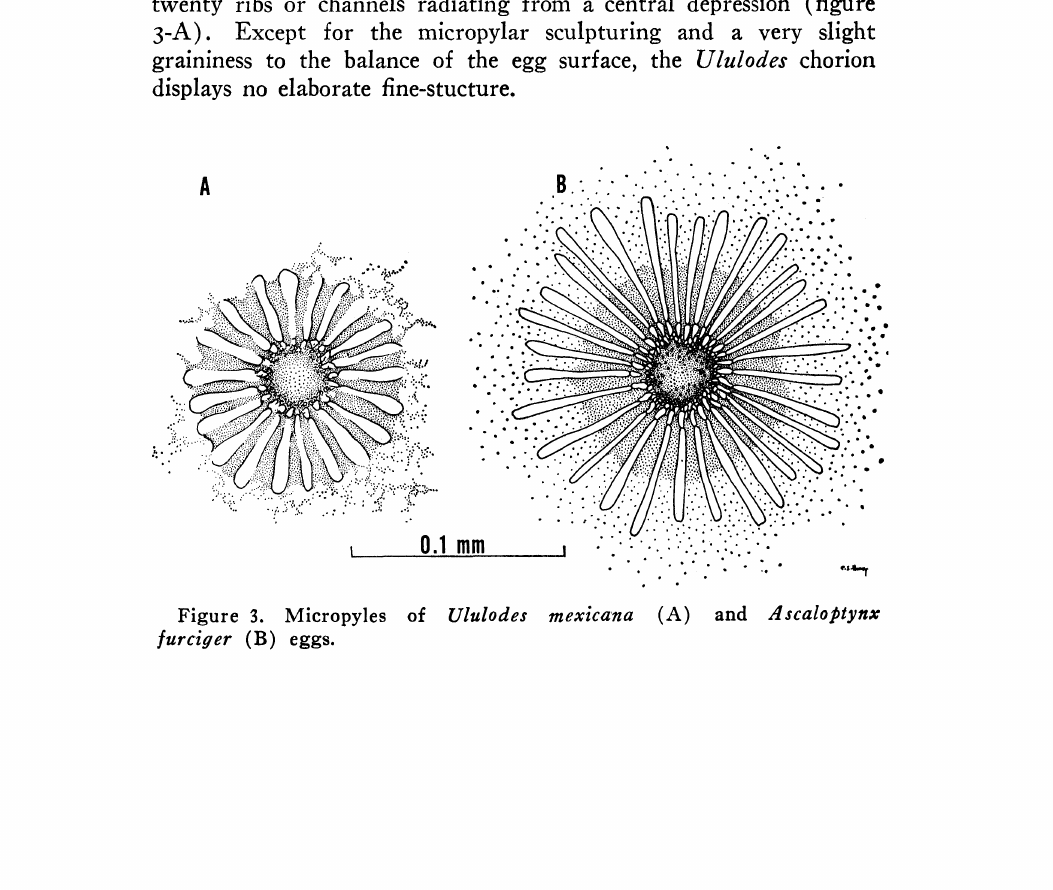
Figure 3. Micropyles of Ululodes mexica’na (A) and ./lscaloptynx furciger (B)